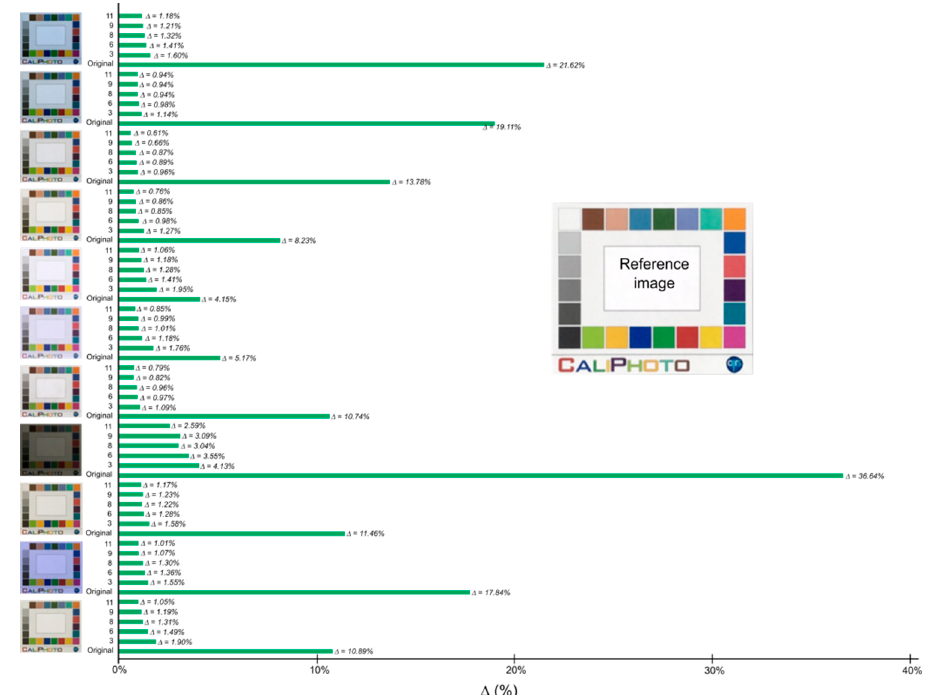
Figure A6. E ff ect of the order of colour correction on the accuracy of CaliPhoto image processing for di ff erent illumination conditions, and original size of the colour plate in pixels. The size of the colour plate in pixels on the original photographs (on the left) are, from top to bottom: 2312 × 1944, 1704 × 1431, 1150 × 962, 633 × 541, 350 × 297, 285 × 237, 1120 × 964, 1132 × 968, 962 × 823, 870 × 736, 1455 × 1236. The reference image is displayed on the right (size of the colour plate on the original photograph, 1242 × 1072). The correction is always best at order 11.